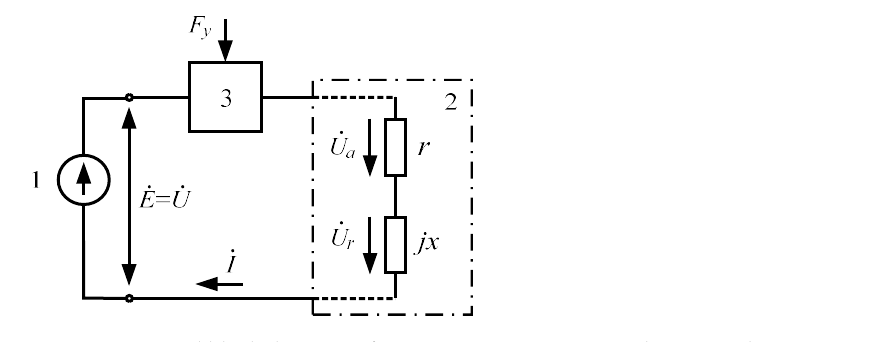
Figure 5. Voltages, a transformed vector diagram. From the analysis of expression (4) and Figure 3, it follows that, when the current vector I  is combined with the real coordinate axis of the complex plane, the mains volt- age vector U  can be conditionally split with respect to the current phase I  into the in- phase (real)